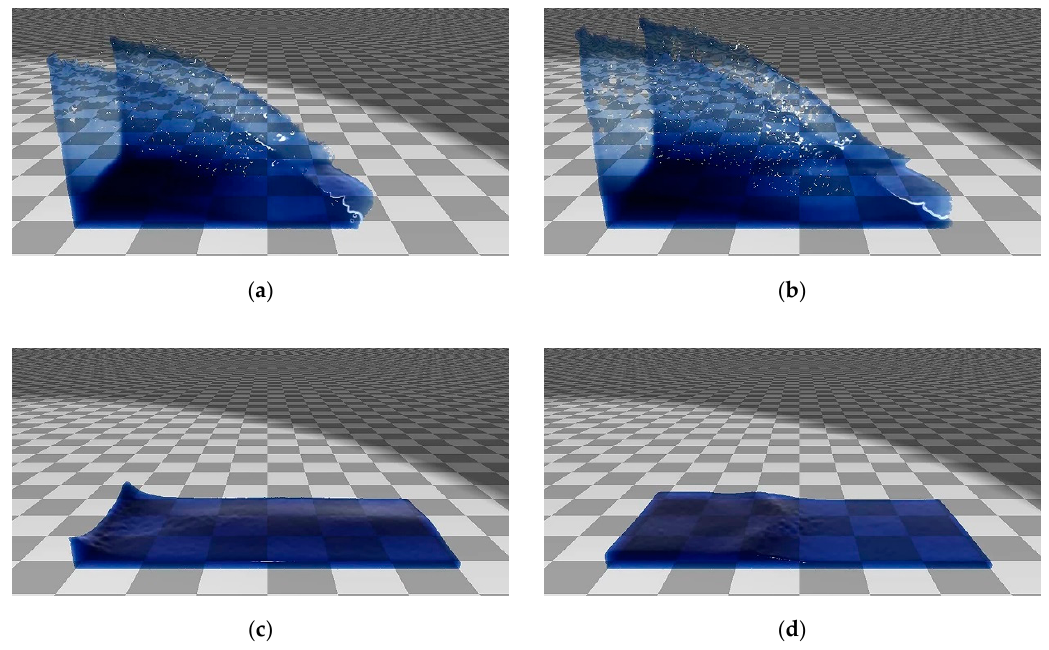
Figure 16. Shading effect of dam break scene using the improved anisotropic screen space fluids technique. The shading effect is implemented using OpenGL. ( a – d ) Images selected from four different time steps in a dam break scene.